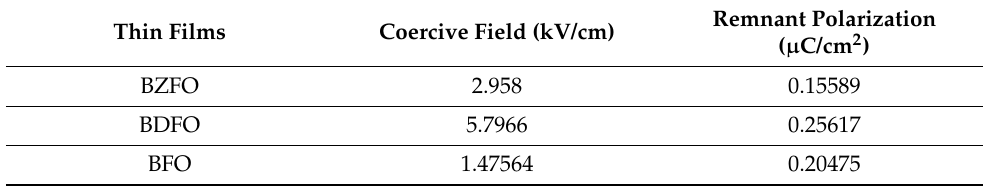
Table 4. Ferroelectric properties of BFO, BDFO, and BZFO thin